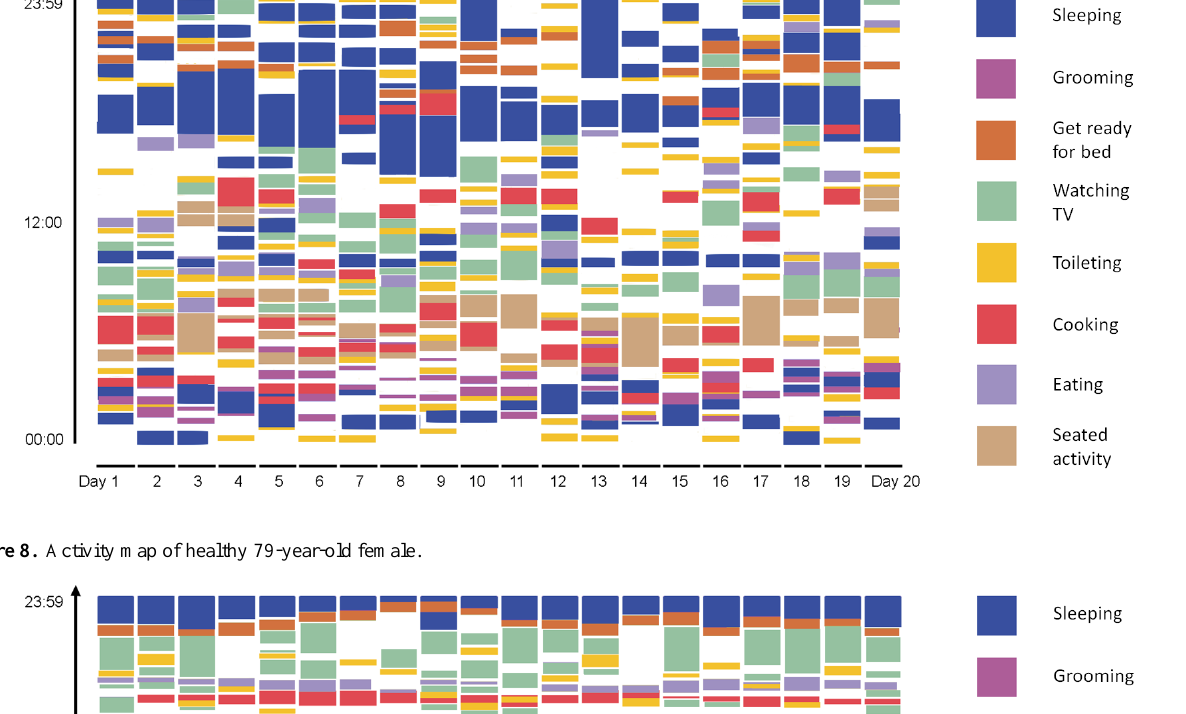
Figure 7. Activity map of 84-year-old female Alzheimer patient.